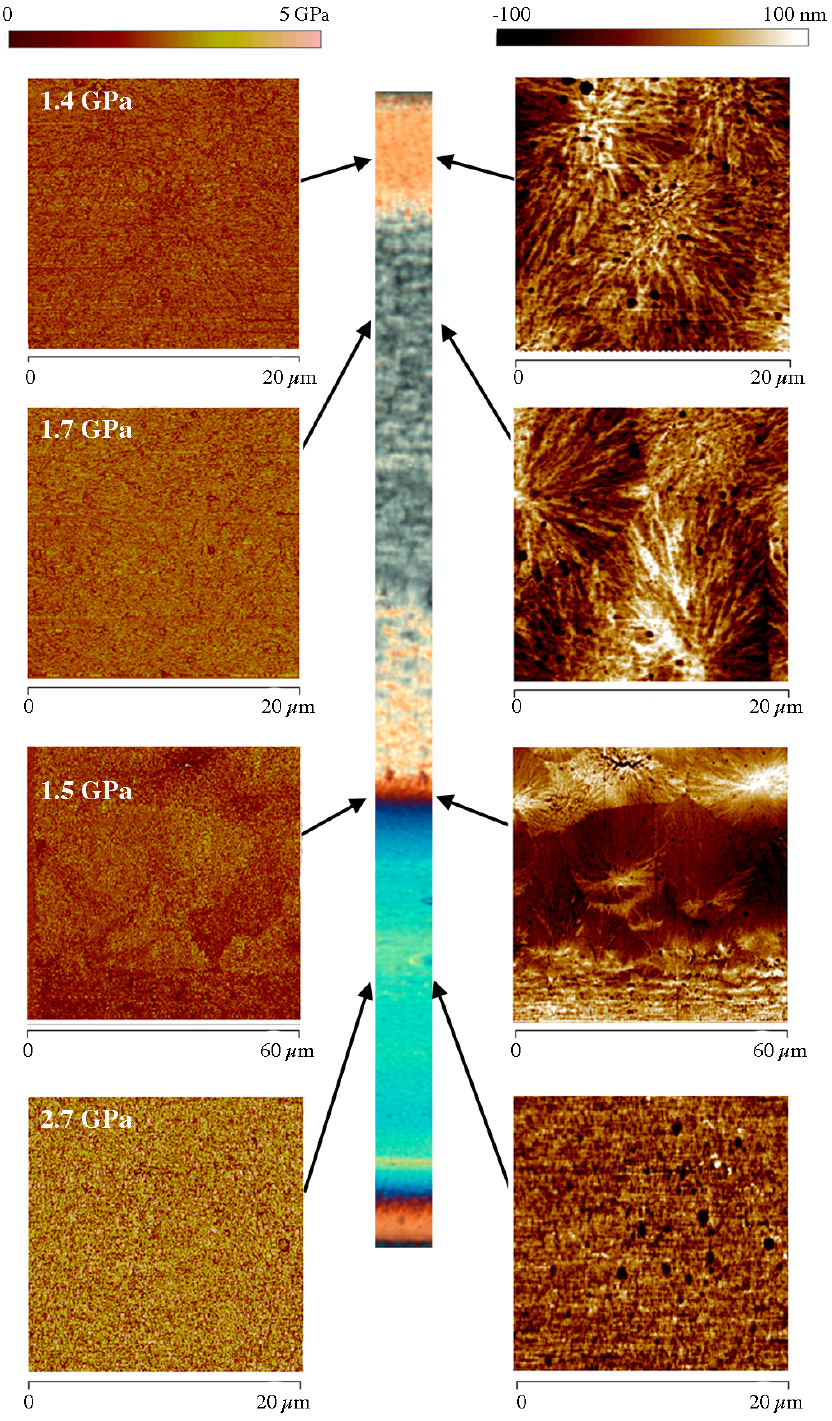
Figure 6. AFM maps, height and modulus, obtained in different zones along the sample thickness, for the sample 120-18. The average moduli are reported in the map of each zone. POM micrographs and AFM maps have all the same alignment with flow direction in the thickness plane.